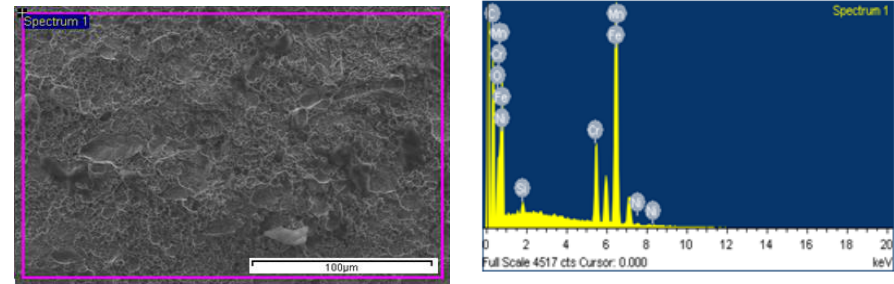
Figure 19. EDS/SEM spectrum analysis of fracture face of TIG heat affected zone. Table 13. Elements present in fracture face of TIG heat affected zone.